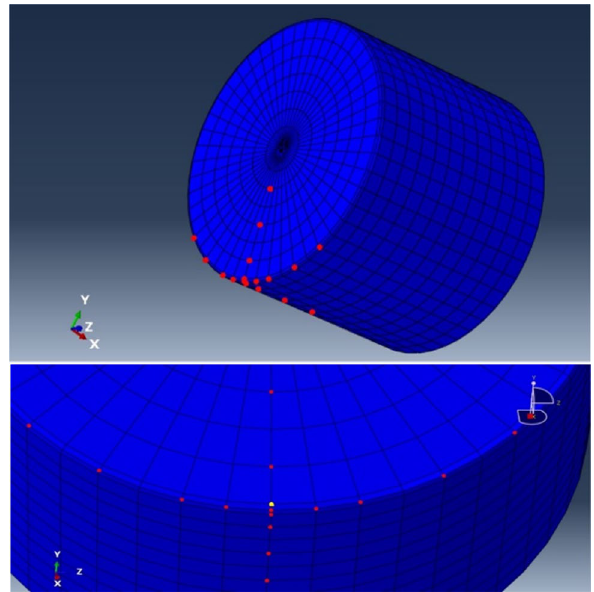
Fig. 10 Chamfered cutter nodes used for the analysis (yellow dot indicates the node with the highest temperature and force)